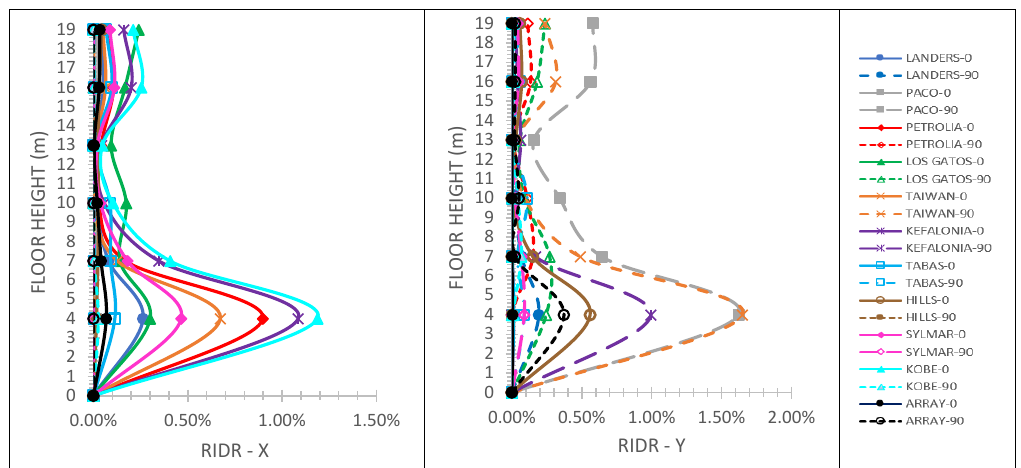
Figure 19. RIDR along X ( left ) and Y ( right ) horizontal directions of the six-story mixed building, considering the fixed connection of the steel structure to the r/c one.